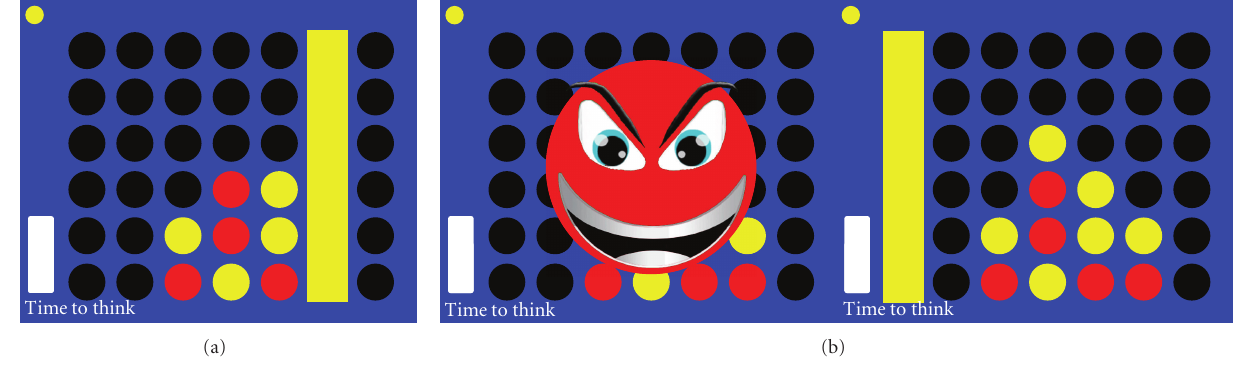
Figure 4: Visual feedback in classic (a) and contest modes